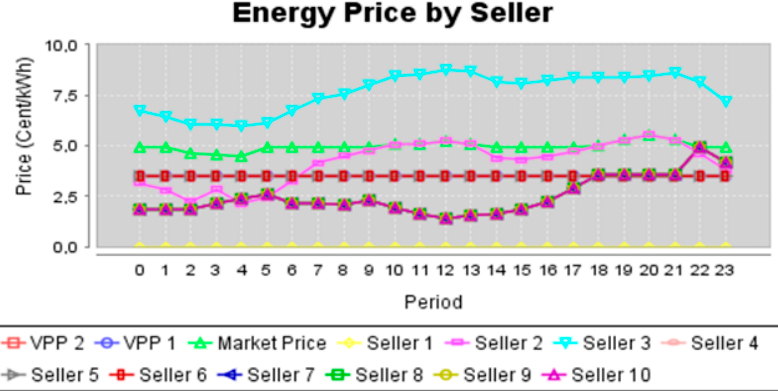
Figure 17. Evolution of sellers’ bids and market price during the simulation day.